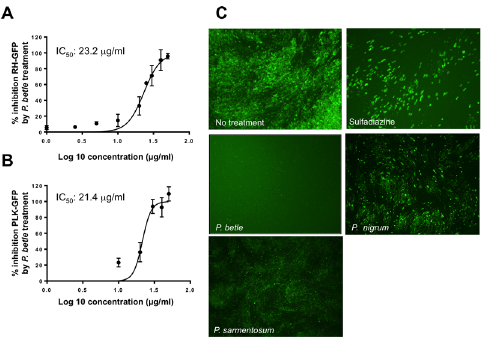
Fig 1. Anti- Toxoplasma activity of P . betle extract on RH-GFP and PLK-GFP Anti- Toxoplasma activity of the P . betle extract on intracellular parasites RH-GFP (A) and PLK-GFP (B). The RH-GFP and PLK-GFP- infected HFF cells were treated with the P . betle extract for 72 h at different concentrations from 0 to 50 μ g/ mL. Data represent the mean values ± SD for three independent experiments. The IC 50 values of the P . betle extract on RH-GFP and PLK-GFP were 23.2 g/mL and 21.4 μ g/mL, respectively. (C) Representative images of T . gondii RH-GFP-infected HFF cells treated with sulfadiazine (1 mg/mL), or either P . betle (50 μ g/mL), P .